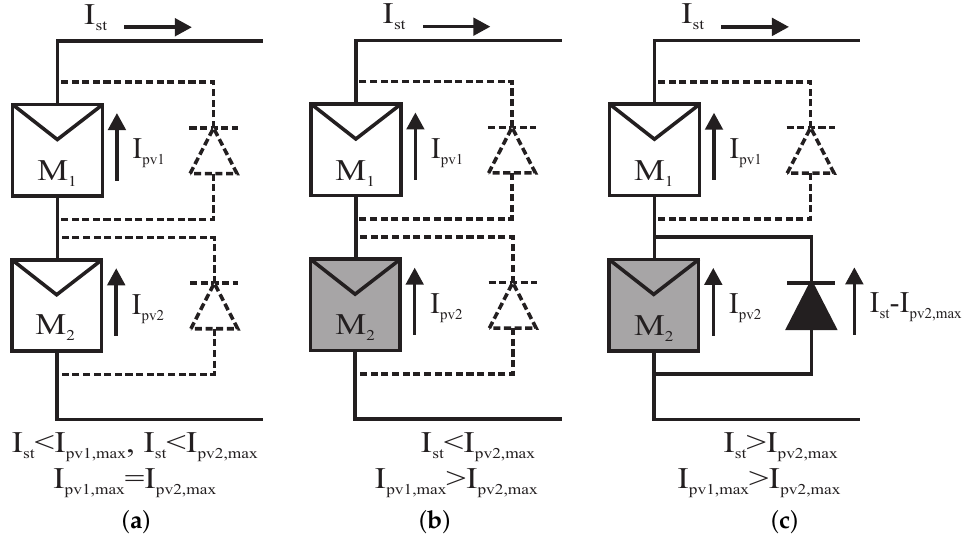
Figure 2. Series-connected PV modules with bypass diodes under uniform and mismatching